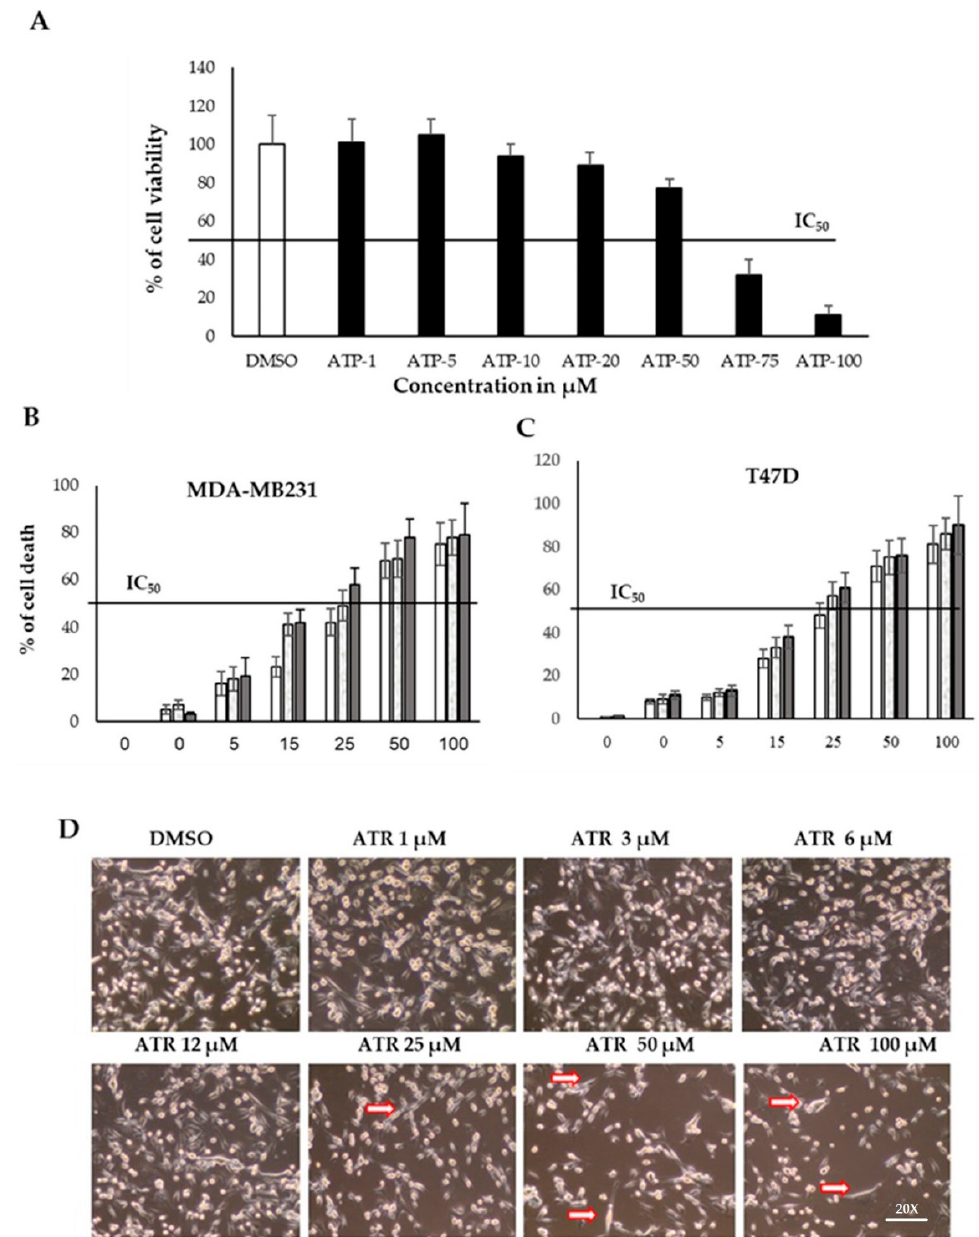
Figure 2. Atropine reduces the proliferation rate of breast cancer cell lines. Cells were supplemented with atropine (0–100 µ mol) for different time periods, and cell viability was assessed with MTT assays. Normal breast cells, MDA-MB-231, and T47D were treated with TGF- β (10 ng/mL) or a vehicle control (0.1% DMSO). Cell viability was quantified after incubating cells with atropine for 48 h for normal cells ( A ), and at time points 24, 48, and 72 h for breast cancer cell lines ( B , C ). The IC 50 value of atropine was more than 50 µ M for normal breast cell lines but was less than 15 µ M for other cell lines. ( D ) Representative images showing the epithelial modification in breast cancer cells, red arrows indicate fibroblast-like cellular structures. Results are expressed as the mean ± SD of triplicate